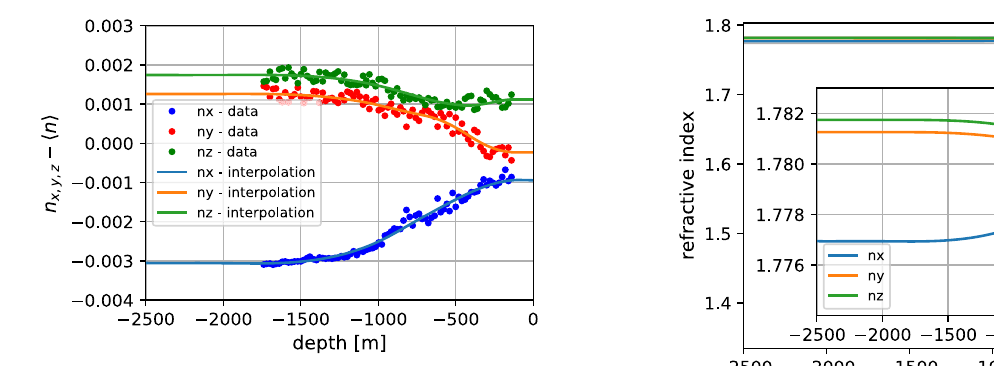
Fig. 1 Refractiveindexasafunctionofdepth.Measuredbirefringence data (scatter) [20] compared to the average index-of-refraction value at thisdepth (cid:3) n ( z ) (cid:4) .Theshownsplineinterpolationofthedata(solidlines) assumes constant extrapolation towards deeper and shallower depths (model A)